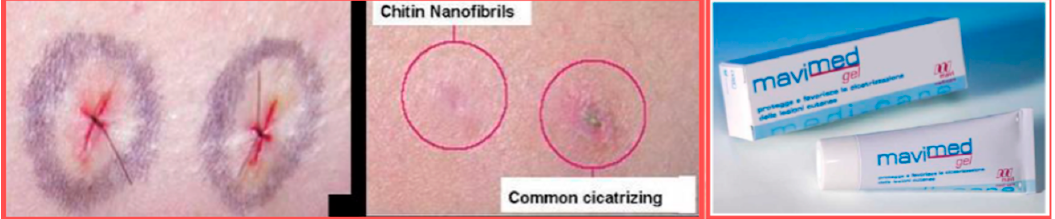
Figure 18. Antibacterial activity of chitin nanofibrils bound to nanostructured silver [56]. 8. Conclusions The pursuit of prevention and wellbeing together with respect for the environment are driving innovation beyond cosmetics. On the one hand, consumers are seeking personalized products respecting nature and obtained through smart technologies. On the other hand, they are also reallocating their interests to premium products that, if characterized by an affordable price, could better fulfill their needs and priorities. Moreover, beauty masks, considered part of the visit in wellness centers (SPAs), represent for the consumer the possibility to access a luxurious and relaxation treatment with the same skin benefits, obtainable from beauty center treatments. The reported and described cosmeceutical tissues could give the same benefits to the consumer, with the advantage of remaining at home. This is the reason 47% of Chinese females used at least one type of facial mask in the morning in the six months to January 2017, while Asia Pacific accounted for 76% of global sheet masks launches in 2016 [80]. From 40 to 50% of the new facial masks launched in South Korea and Japan reported an anti-aging claim, while only 25% claimed the same in China. However, 47% of female facial mask consumers (aged 20–49 in 2017) used these special cosmetics with pore- refining purposes, while 39% used them to reduce fine lines and wrinkles. In addition to Asia-Pacific countries, analysts have identified other emerging economies such as Indonesia, Argentina, Brazil, and India as lucrative markets for sheet face masks for the next few years. Thus, it seems necessary to offer to consumers different skin care benefits in a convenient manner and a short turnaround time, capturing their imagination and proposing innovative natural products made by new technologies, as the reported cosmeceutical fabric. For all these reasons, these innovative cosmeceutical tissues, being free of preservatives, emulsifiers and other chemicals and totally biodegradable, could be considered safer end ecofriendly. In conclusion, through this technology, it seems possible to create a new and innovative category of cosmeceuticals, engineered as nonwoven biodegradable tissues and able to restore and regenerate structure and function of aged, photoaged or diseased skin. Naturally, the effectiveness and safeness of these innovative cosmetics must be controlled by in vitro and in vivo methodologies, as reported,